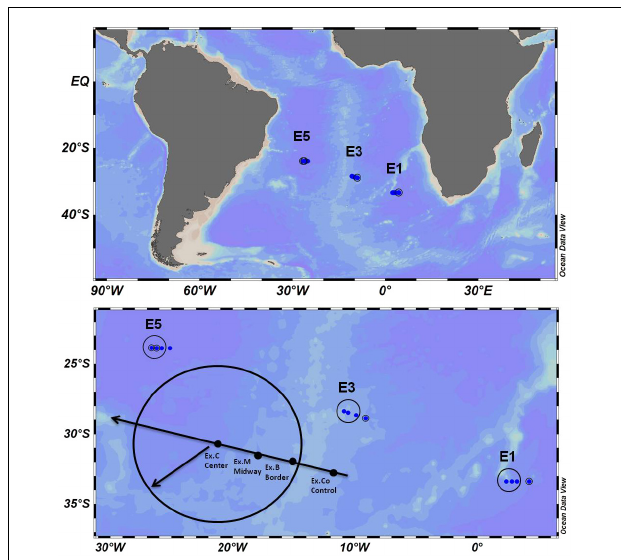
FIGURE 1 | Ocean Data View (ODV) Sampling maps (a and b—sample scheme) of eddies in the South Atlantic (E1, E3, and E5, control: Co—outside, border: B, midway: M and center: C of the